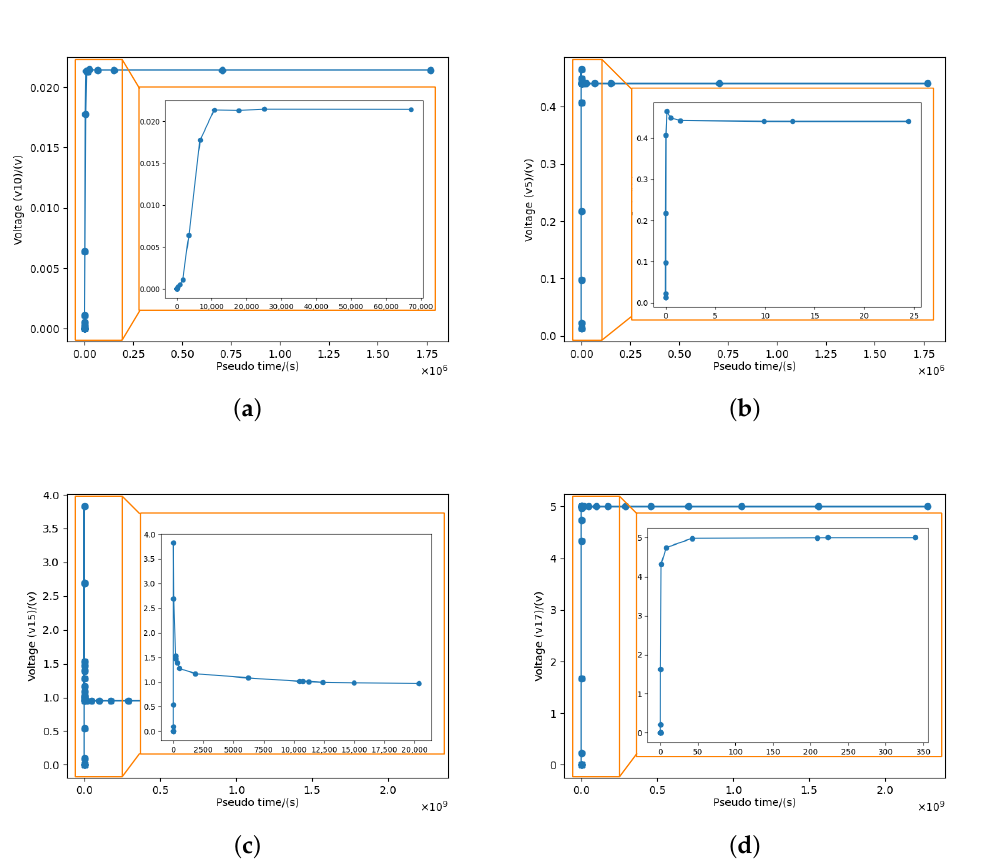
Figure 8. The voltage waveforms of “THM5” and “slowlatch” at different nodes under the proposed method. ( a ) The node 10 voltage waveform of the “THM5” circuit. ( b ) The node 5 voltage waveform of the "THM5" circuit. ( c ) The node 15 voltage waveform of the “slowlatch” circuit. ( d ) The node 17 voltage waveform of the "slowlatch" circuit.